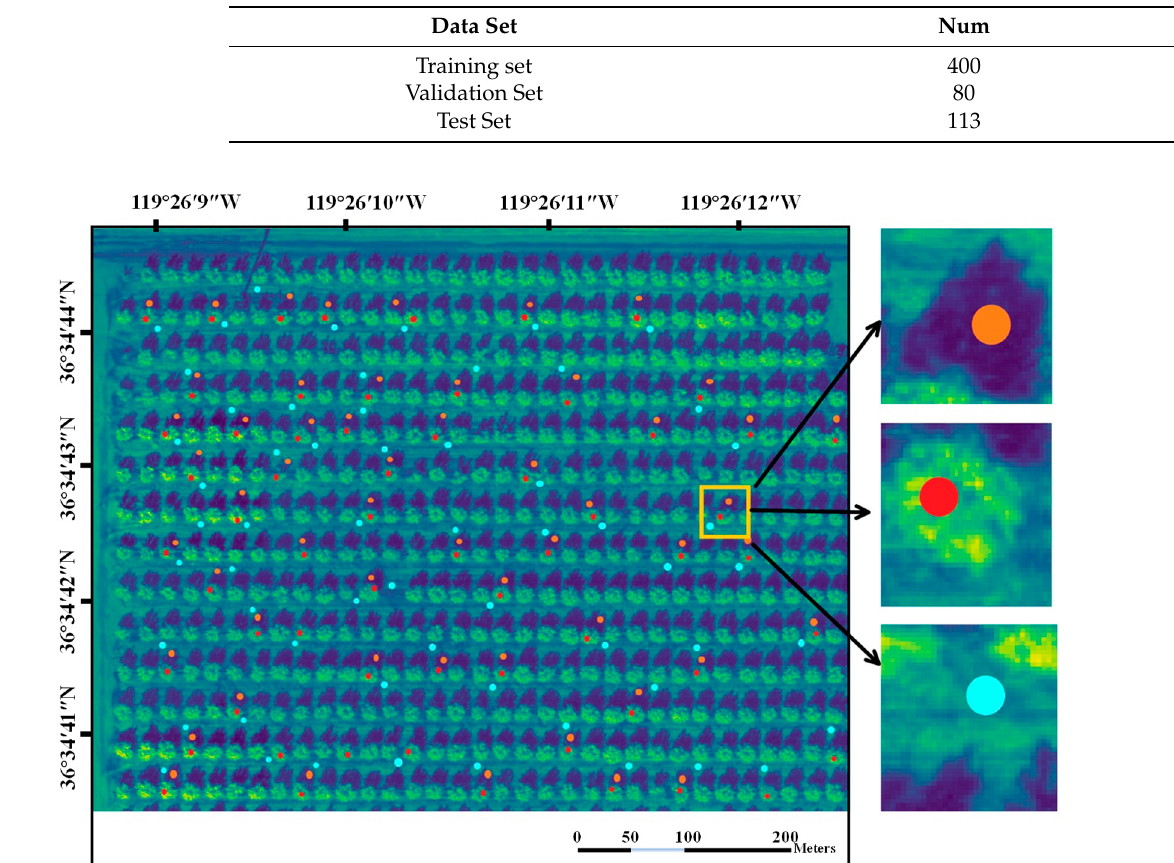
Table 1. Data distribution of the dataset.